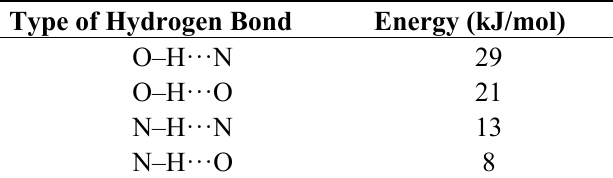
Table 3. Types of hydrogen bonds in studied dimethacrylates and corresponding energies